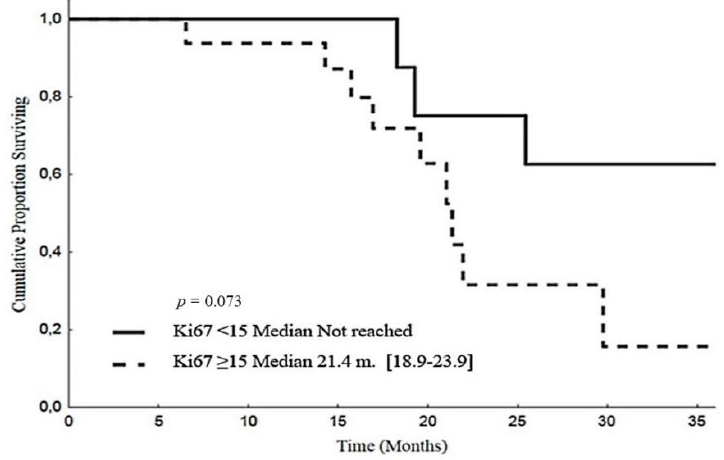
Figure 6. Progression-free survival according to Ki67 after post-EDP surgery.